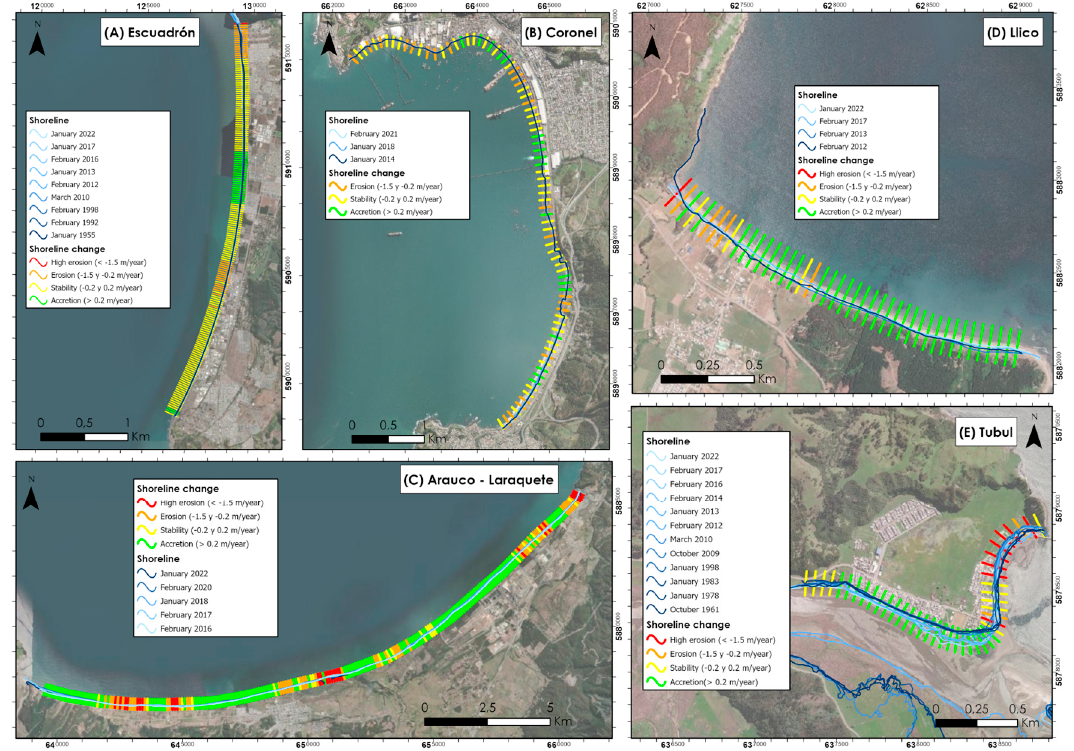
Figure 6. Spatial distribution of erosion rates on the Arauco Gulf beaches during summer. ( A ) Escuadrón beach, ( B ) Coronel beach, ( C ) Arauco beach, ( D ) Llico beach and ( E ) Tubul beach.